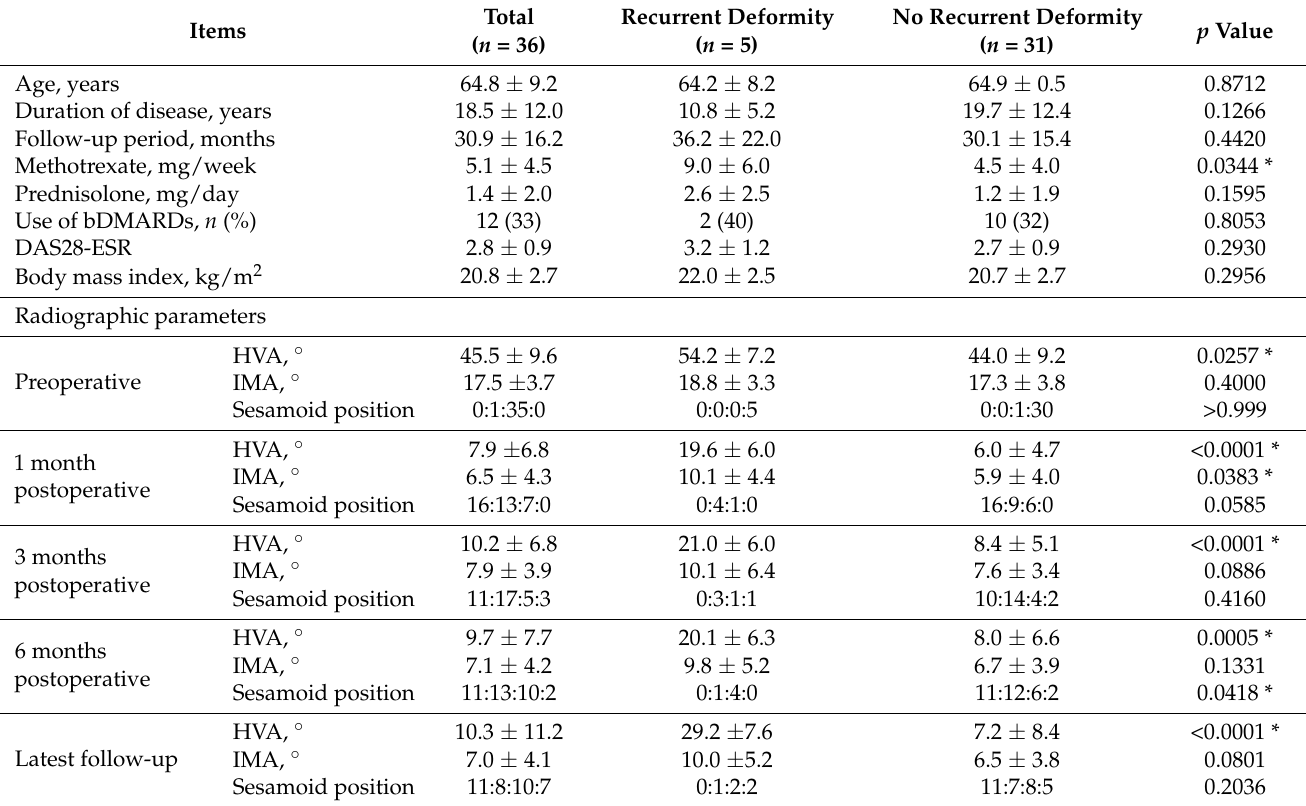
Table 2. Comparisons of patient demographics and radiographic findings between cases with and without recurrent hallux